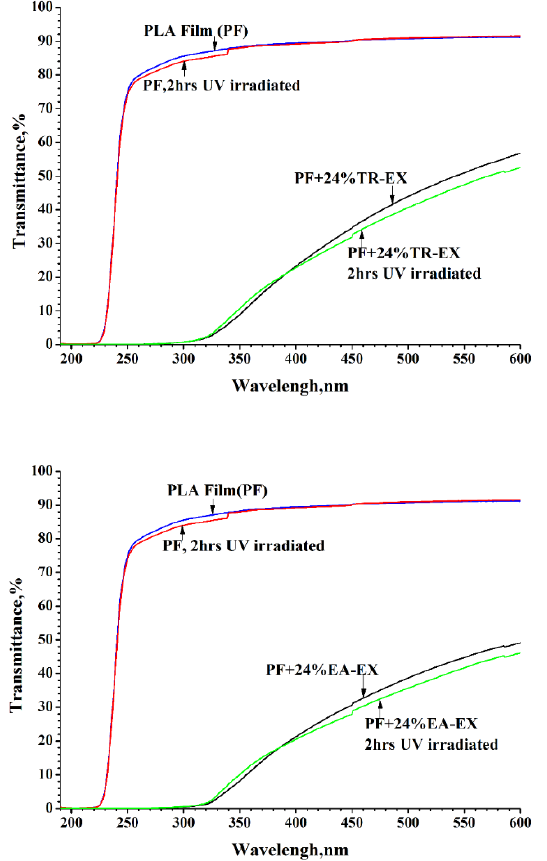
Figure 8. Comparison in the UV stability of the neat PLA film (PF) and the UV shielding film (UV-SF) with 24% extractive under strong UV irradiation.